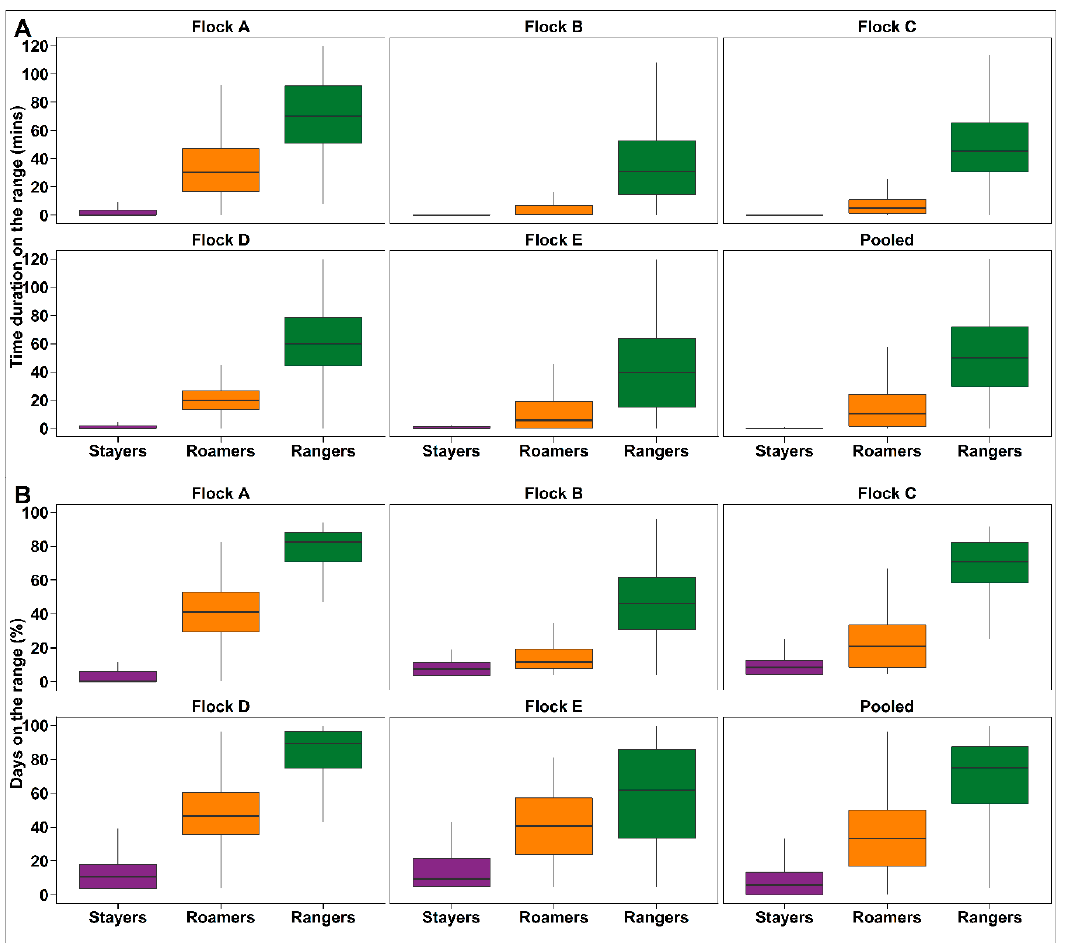
Figure 1. Box plot representing the identified ranging sub-populations of stayers (purple), roamers (orange), and rangers (green). The horizontal lines on the box plot represent the lower quartile, median and upper quartile. Figure 1A shows the mean time duration / hen / day of stayers, roamers and rangers on the range as determined for each of the five flocks investigated, as well as the pooled cohort. Figure 1B shows the percentage of days that the hens of the respective sub-population spent on the range. These results obtained when hens were between 18 and 21 weeks of age, were then used to classify and rearrange hens so individuals of the same category were placed together in their dedicated experimental shed subsection where they lived for the remaining laying period (until 74 weeks of age).